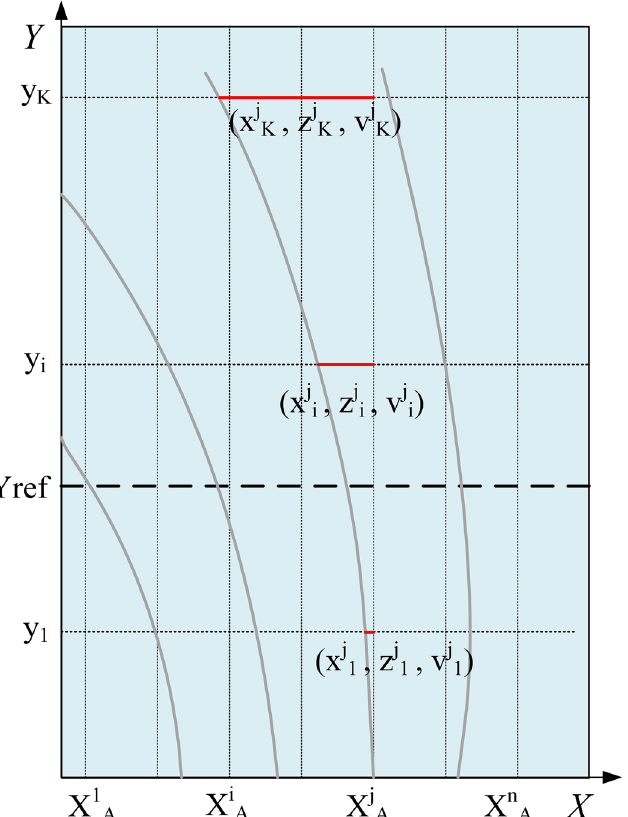
Figure 5. Anchor representation.